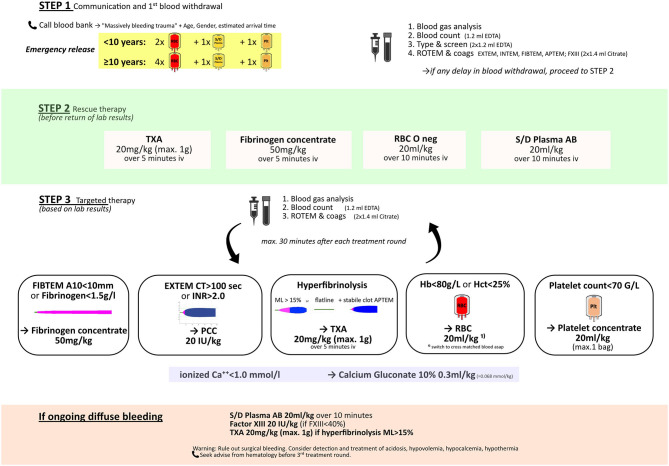
Example of a goal-directed pediatric bleeding management algorithm. TXA, tranexamic acid; RBC, red blood cells; S/D plasma AB, solvent/detergent pooled plasma, blood group AB.